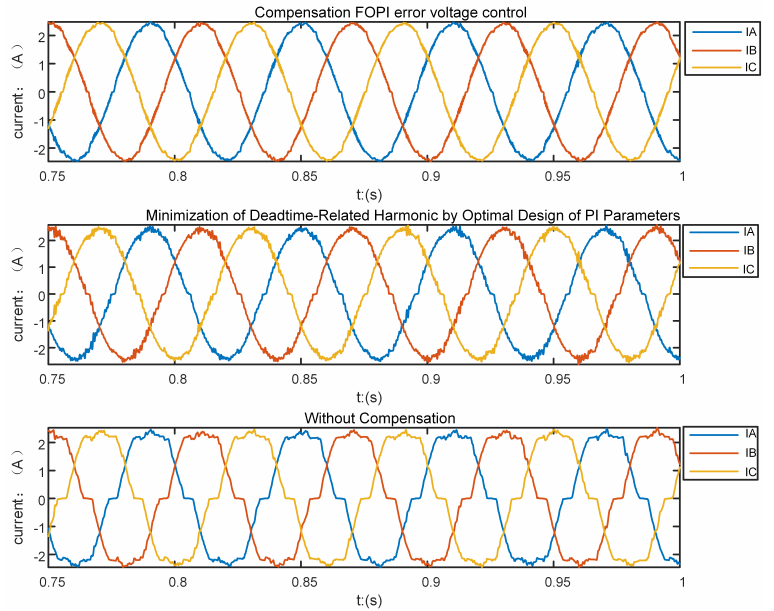
Figure 32. Comparison of three phase current respons under 200 r/min speed